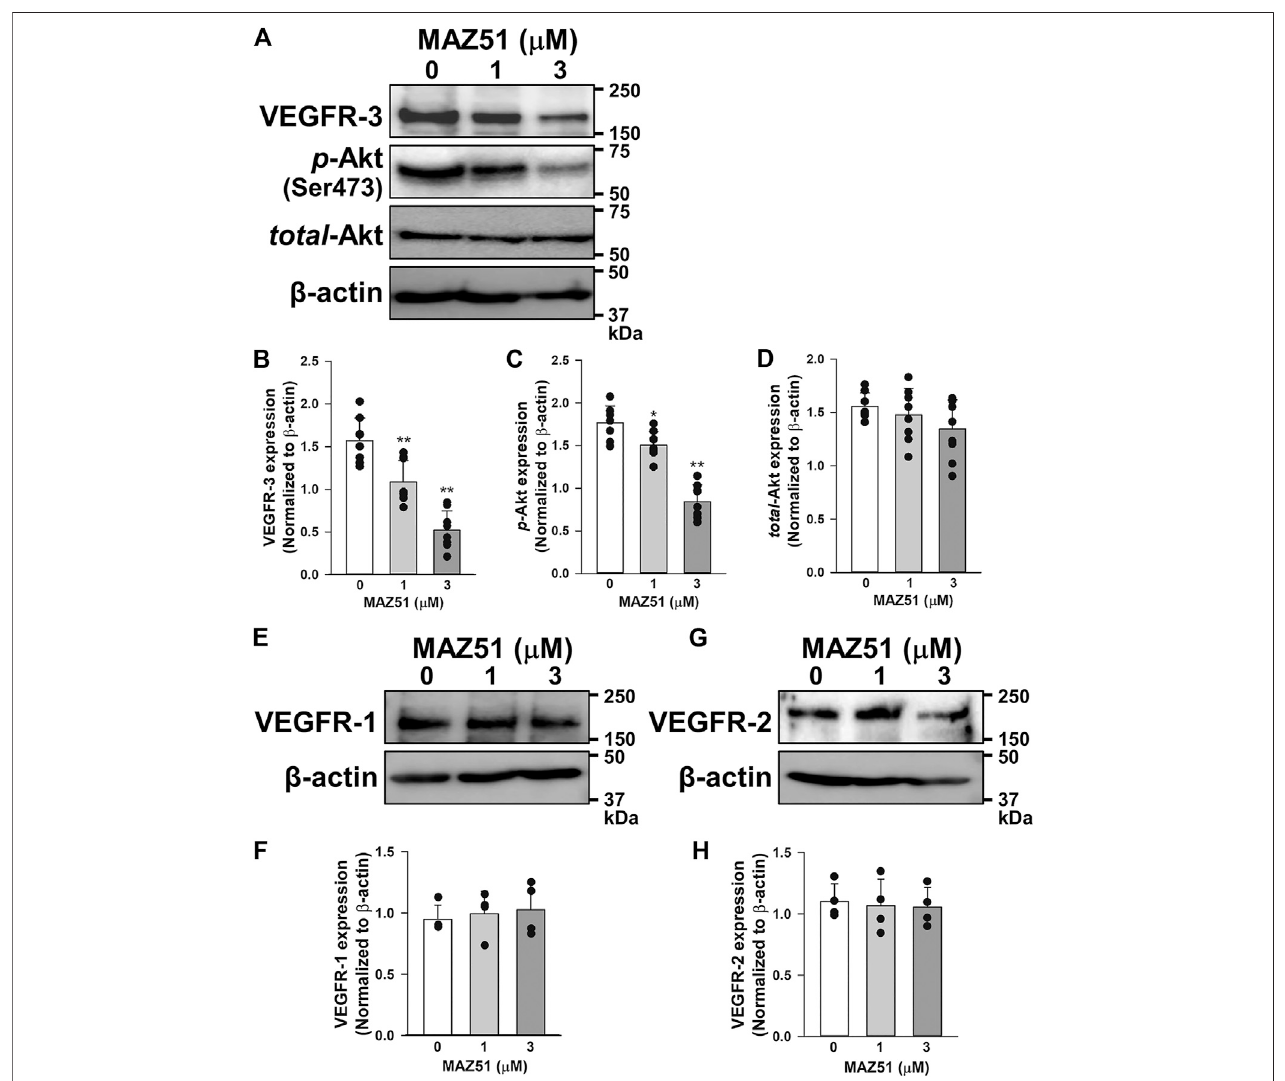
FIGURE6| Down-regulationofVEGFR-3expressionand p -AktlevelsbyMAZ51.TheeffectsofMAZ51onVEGFRexpressionanditsdownstreamsignalpathway, Akt, were examined in human prostate cancer PC-3 cells by Western blotting. (A) Representative blots of VEGFR-3, p -Akt (Ser473), and total -Akt in the absence and presenceof1and3 μ MMAZ51for48 hinPC-3cells. (B – D) TheexpressionlevelsofVEGFR-3 (B) , p -Akt (C) ,and total -Akt (D) intheabsenceandpresenceofMAZ51in PC-3 cells ( n (cid:1) 8). (E,F) Representative blots (E) and the expression levels (F) of VEGFR-1 in the absence and presence of MAZ51 in PC-3 cells ( n (cid:1) 4). (G,H) Representativeblots (G) andtheexpressionlevels (H) ofVEGFR-2intheabsenceandpresenceofMAZ51inPC-3cells( n (cid:1) 4).Theseexpressionlevelswerenormalized by that of β -actin. Data are presented as means ± S.D. * p < 0.05, ** p < 0.01 vs. 0 μ M MAZ51 (Scheffé ’ s test following ANOVA).